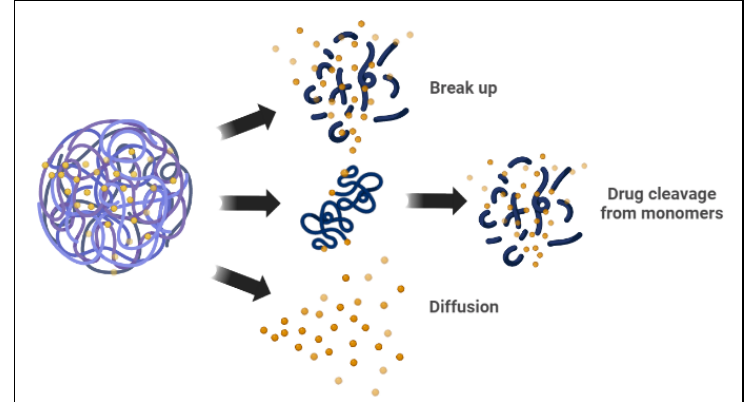
Figure 3. Drug release mechanisms from polymeric micelles.